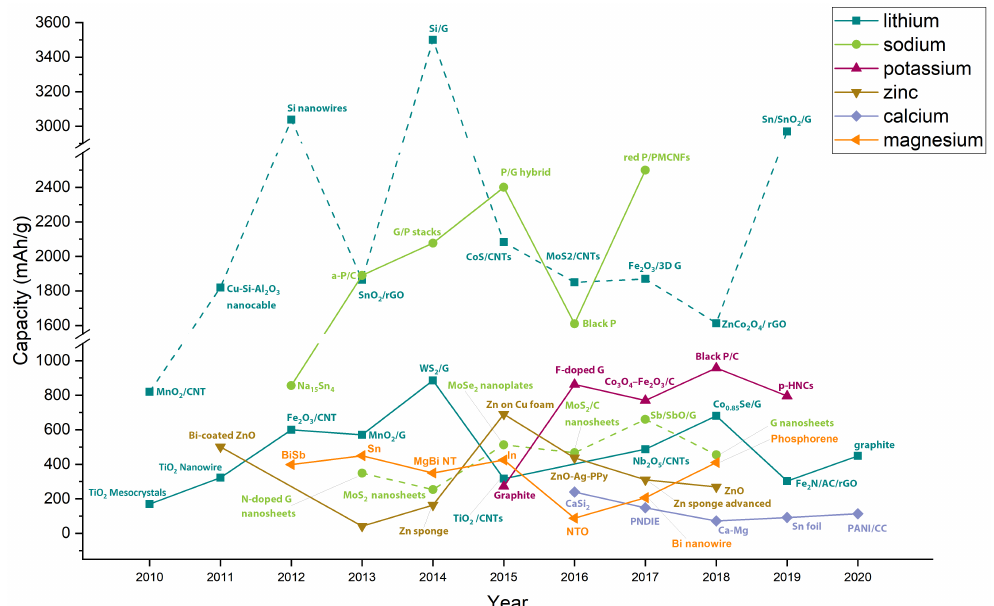
Figure 8. The advance of the anodes’ experimental specific capacity, comparing the seven battery types: Li, Na, K, Zn, Ca, Mg, and Al. Continuous line: traditional intercalation materials. Dot lines conversion materials. Graph constructed by the authors from references in Tables 2–7.